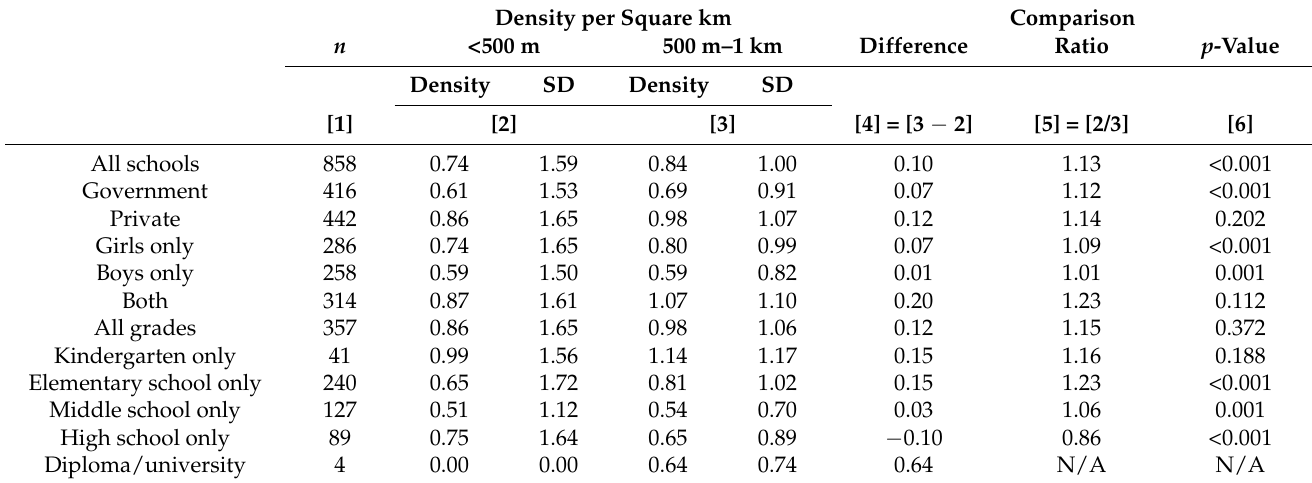
Table 2. Density of fast food outlets around schools in Riyadh City. Density per Square km Comparison